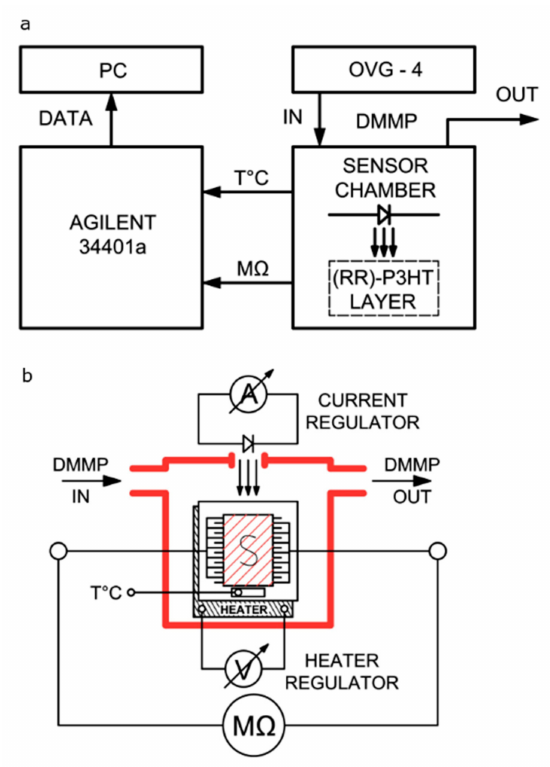
Figure1. Thesensingpropertiesmeasurementset-up: ( a )blockscheme, ( b )sensorchambercross-section with a distance between the LED and the sample ≈ 5